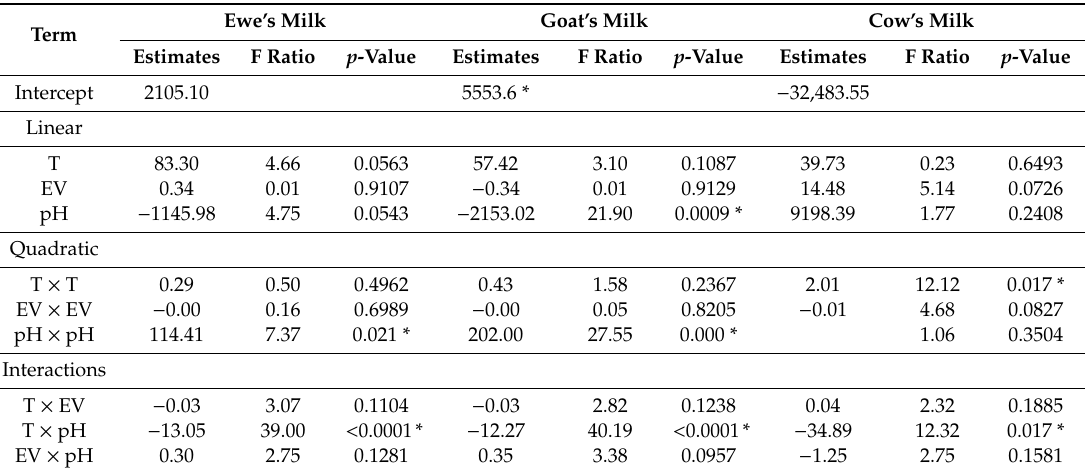
Table 2. Estimated coe ffi cients of the predicted second-order polynomial model for the milk clotting activity of O. tauricum